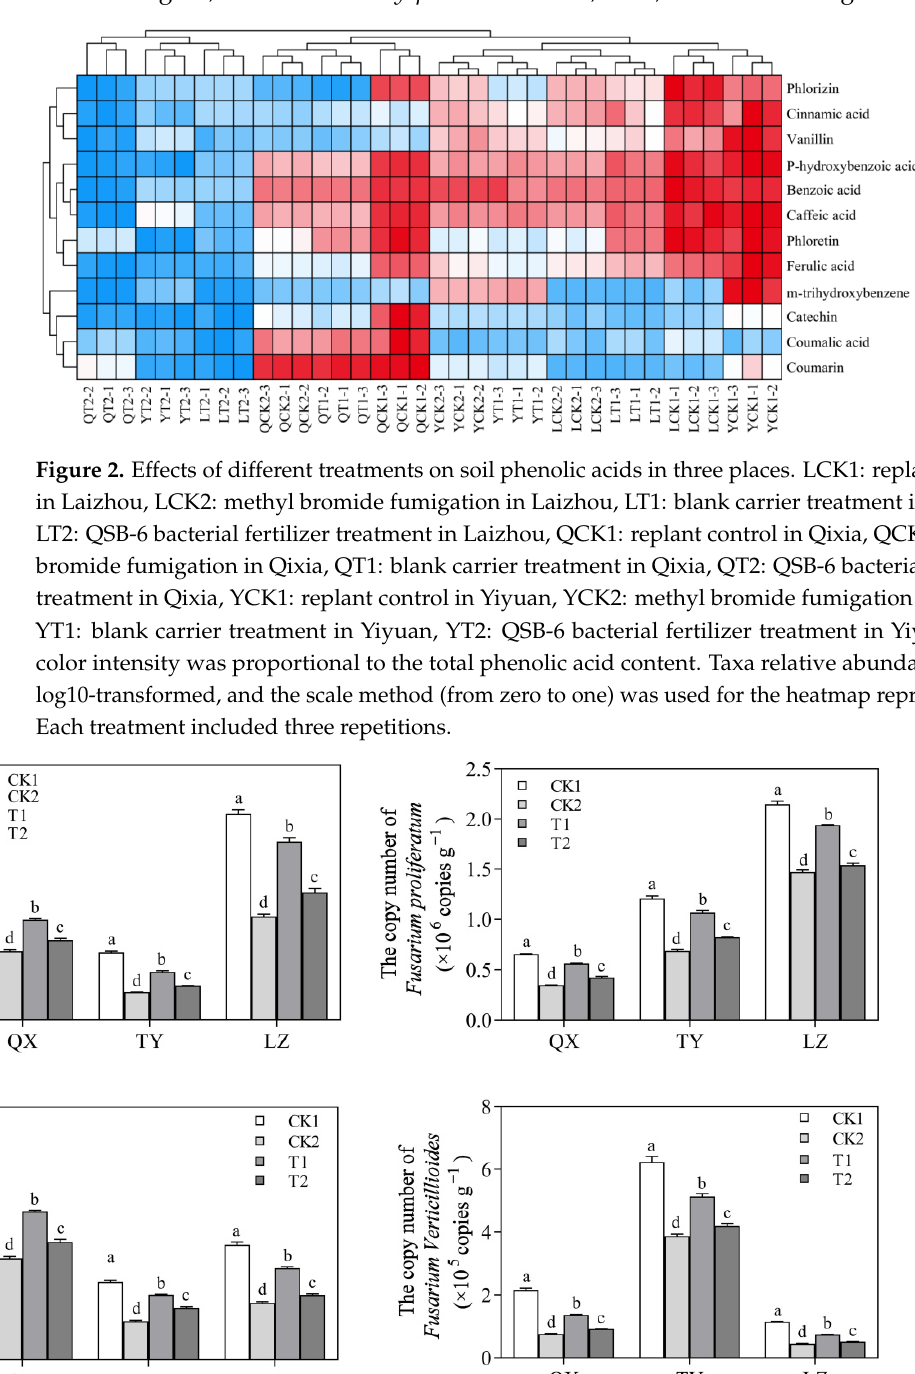
Figure 3. Effect of different treatments on the copy number of four species of Fusarium in blank carrier treatment, T2: QSB-6 bacterial fertilizer treatment. Columns with the same letter for each place are not significantly different based on the Duncan multiple range test at p <